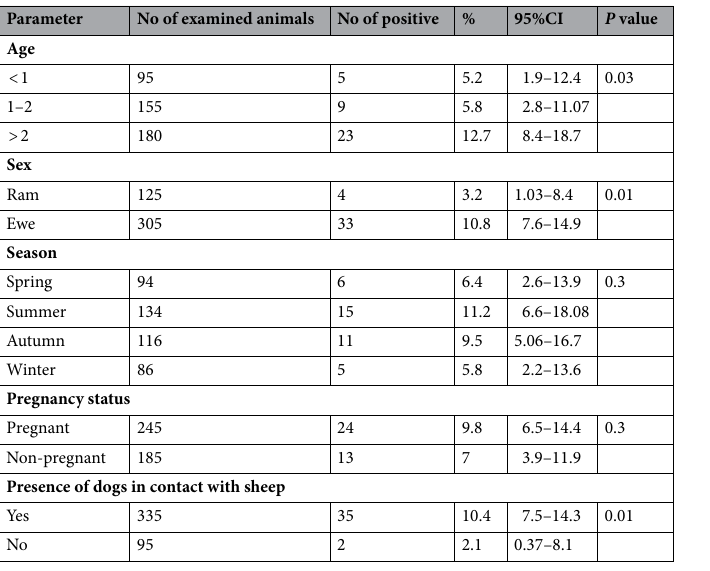
Table 2. Prevalence of anti- N. caninum antibodies in sheep in relation different variables. 95% CI, 95% confidence interval. The result is non-significant at P > 0.05. The result is significant at P < 0.05.